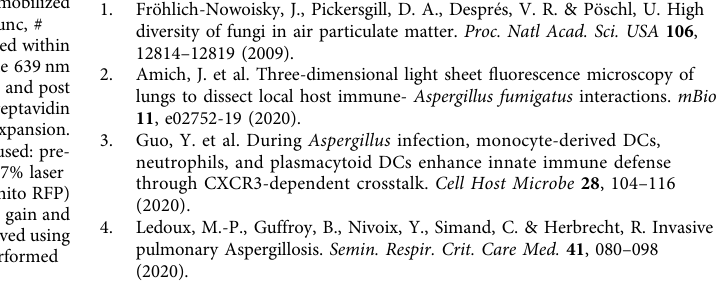
Figshare. https://doi.org/10.6084/m9. fi gshare.c.5577690.v1 73 . Further image stacks are available from the corresponding author upon reasonable